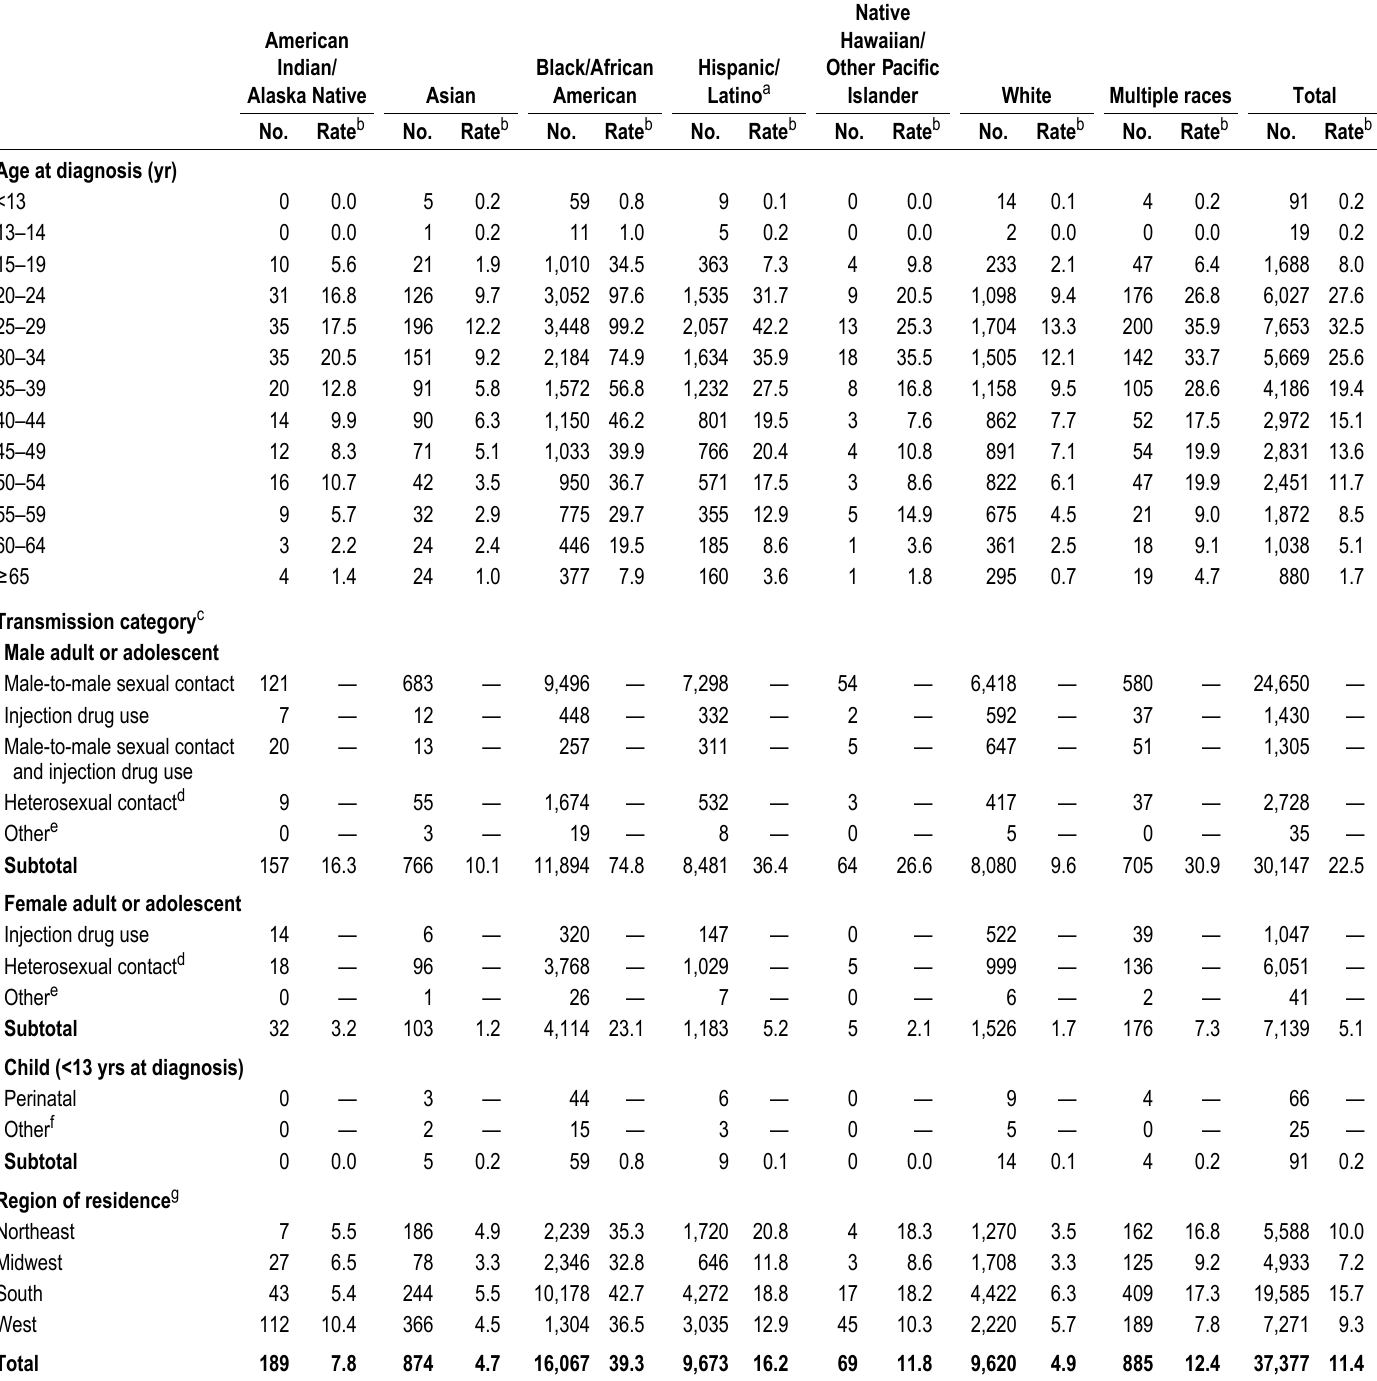
Table 3a. Diagnoses of HIV infection, by race/ethnicity and selected characteristics, 2018—United States American